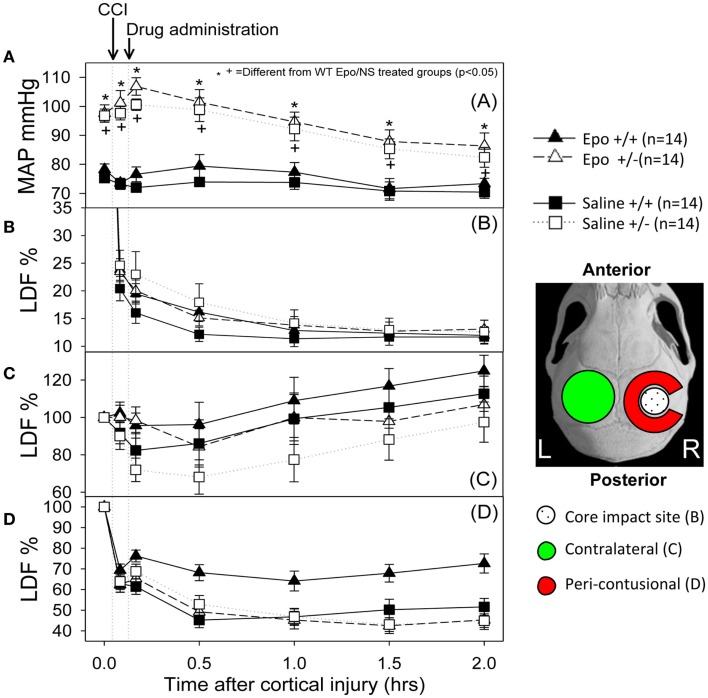
Hemodynamic response to the controlled cortical impact (first arrow) followed by administration of the assigned treatment (second arrow). (A) Mean arterial pressure (MAP) changes during the experiment. The animals that were deficient in eNOS had a higher pre-injury MAP and had a greater drop in MAP after injury than the wild-type animals. When the group × time interaction was significant, symbols indicate which treatments were significantly different among the treatments’ groups by the Holm-Sidak post hoc test. (B–D) Cerebral blood flow response measured by laser Doppler in the core (B), contra-lateral (C) and peri-contusional (D) cerebral cortex. The core had a severe persistent drop in CBF regardless of the animal genotype or treatment group. The contra-lateral cortex showed a small to no decline followed by increased perfusion in all groups. In the peri-contusional regions, Epo treatment effect was seen in the WT animals but not in the eNOS-deficient animals (N = 14 per group).